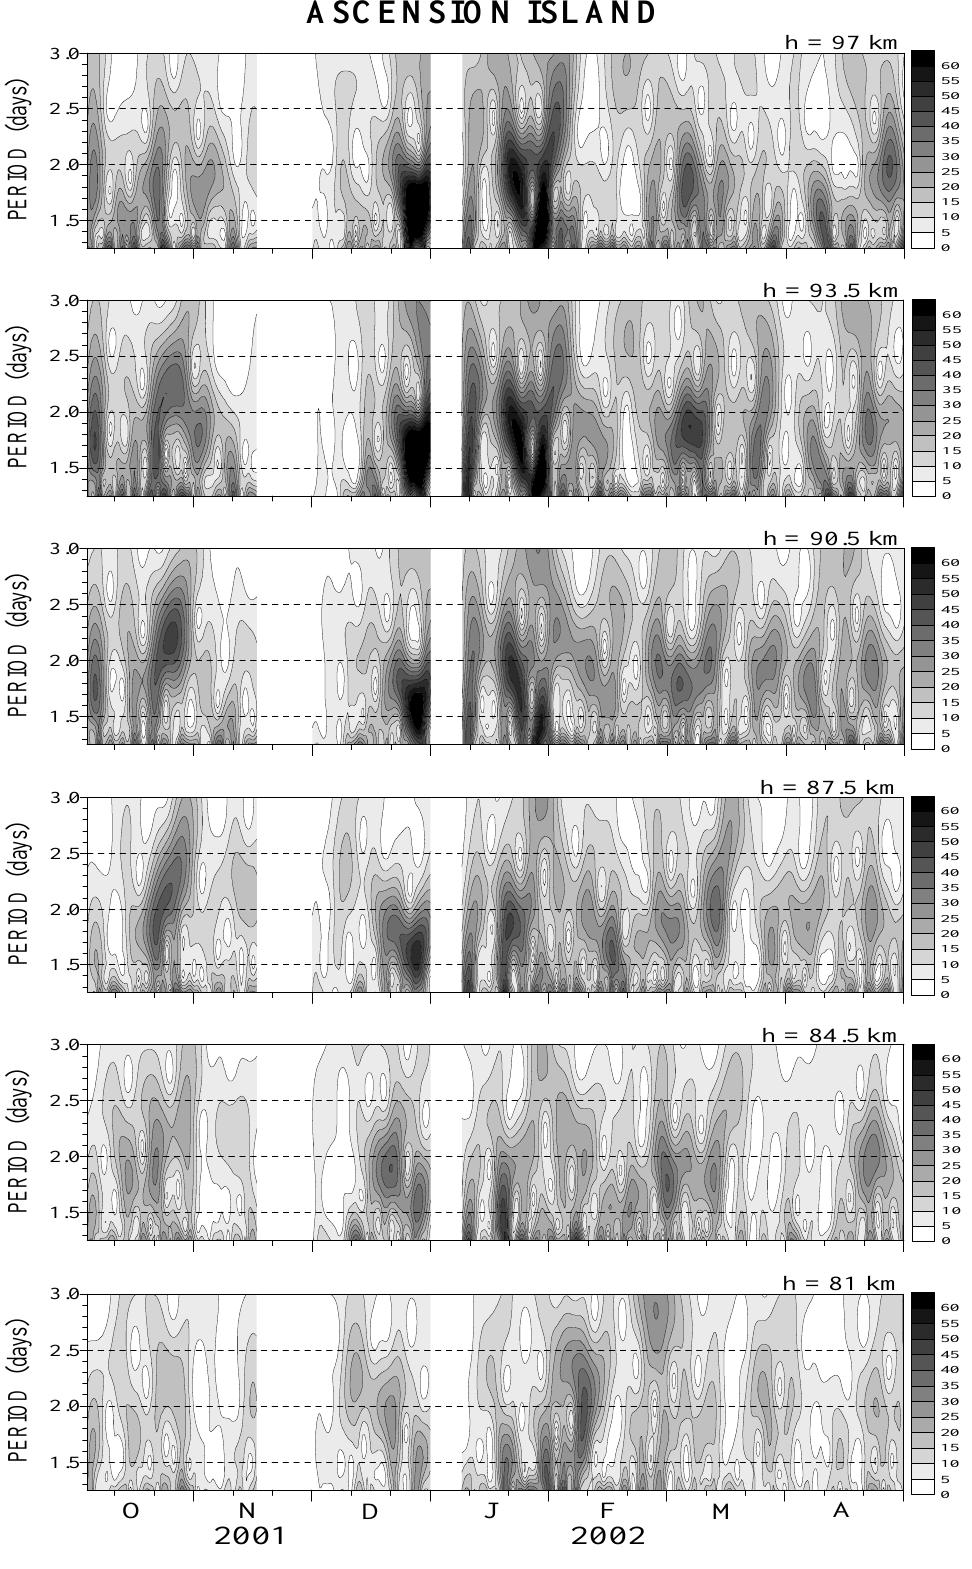
Fig. 7 Fig. 7. Wavelet transform of the meridional wind observed by meteor radar in the interval 05 Oct. 2001–30 Apr. 2002. The spectra are calculated in the period interval 30–72h and for six